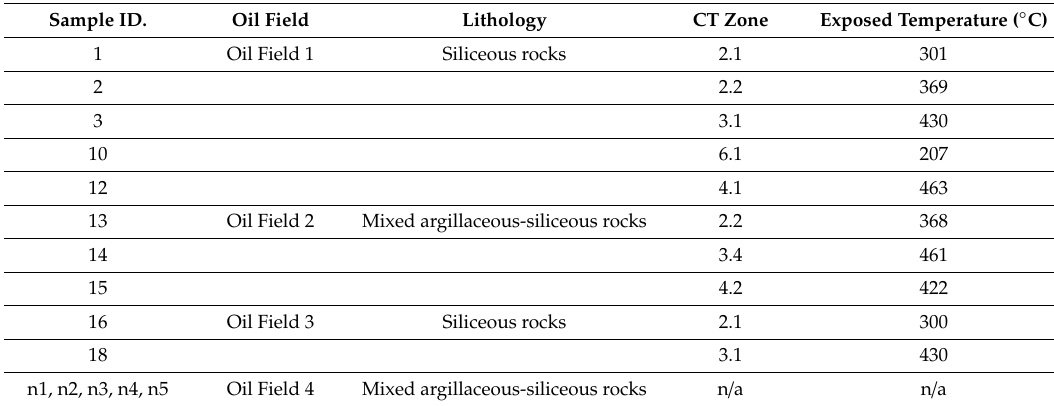
Table 3. List of the investigated